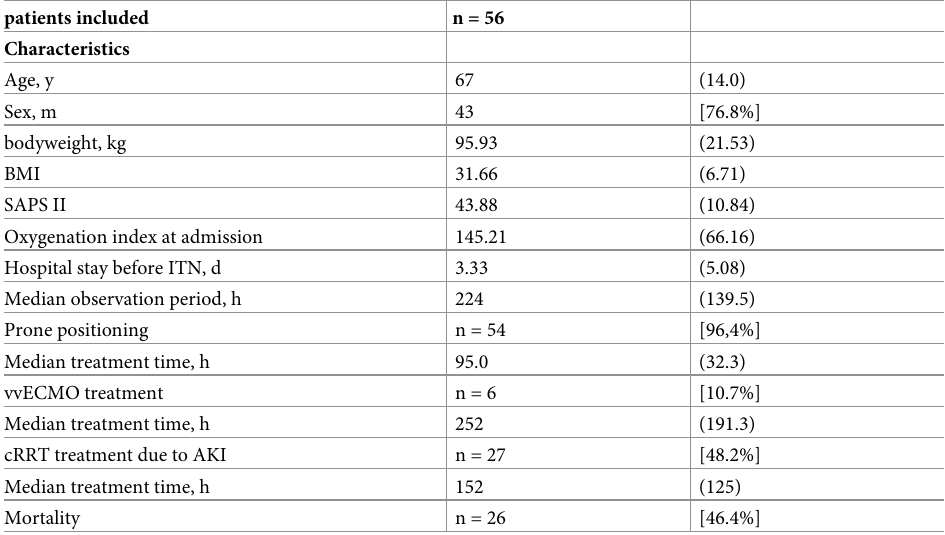
Table 1. Clinical characteristics of C-ARDS patients.